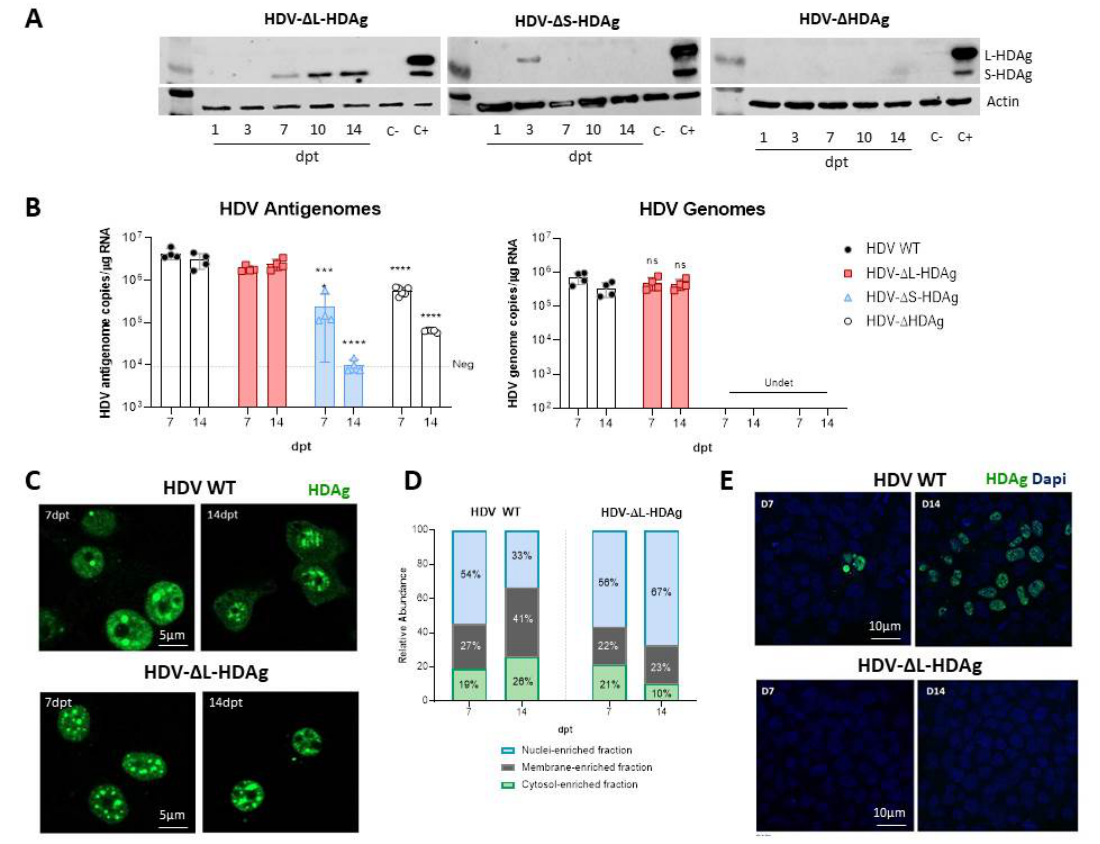
Figure 2. HDV mutants affecting S-HDAg and L-HDAg expression were generated and characterized in Huh-7 cells. ( A ) HDAg expression was assessed in Huh-7 cell lysates by Western Blot at 1-, 3-, 7-, 10- and 14-dpt. ( B ) HDV genomes were produced after transfection with the plasmids that express S-HDAg: HDV WT and HDV- ∆ L-HDAg. (ns: no significant, *** p < 0.001, **** p < 0.0001). ( C , D ) HDAg localization was examined by immunofluorescence (scale bar: 5 µ m) and by cell fractionation. The percentage of HDAgs present in the cytosolic-, the membrane- and the nuclear-enriched fractions was determined at 7- and 14-dpt. ( E ) Huh-7.5.1-hNTCP cells were infected with supernatants from HBV/HDV WT, and HBV/HDV- ∆ L-HDAg co-transfected cells collected at 7- and 14-dpt. At 7 days post-infection (dpi), cells were fixed and immune stained with human serum for HDAg detection. Scale bar: 10 µm.